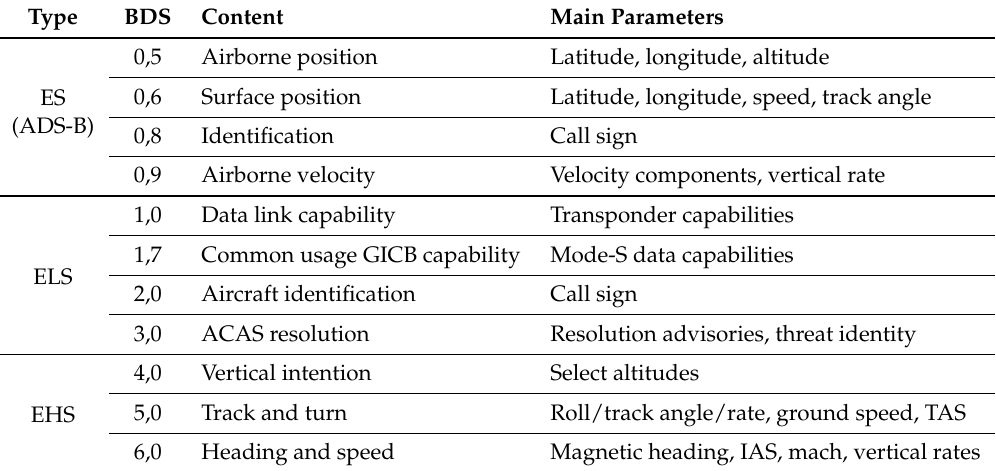
Table 1. Overview of different Mode S services, BDS codes, and related information.